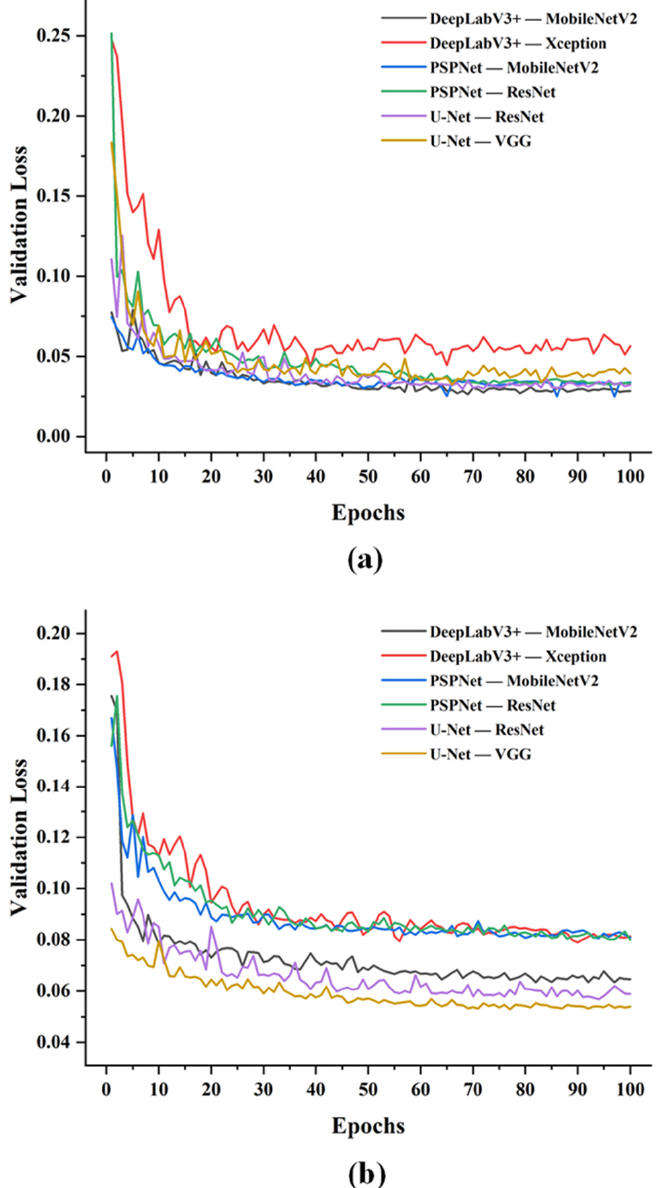
Figure 5. Validation curves of loss against number of epochs on identifications of ( a ) apple leaves and ( b ) disease areas. and ( b ) disease